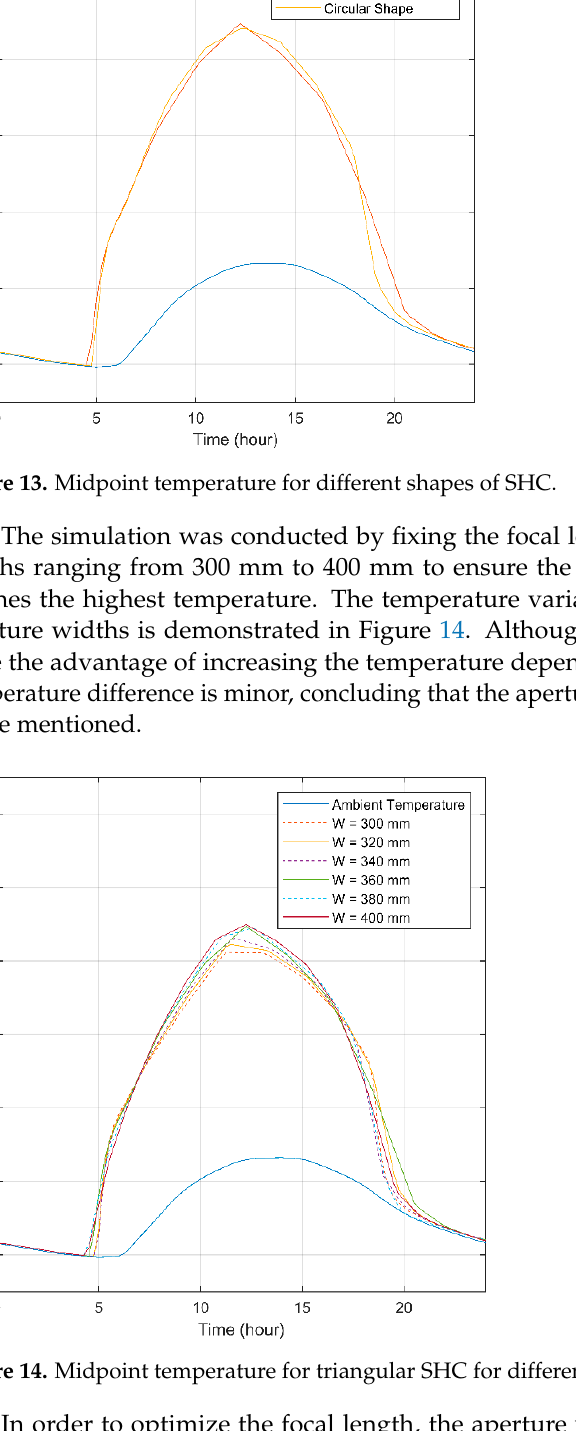
Figure 15. Midpoint temperature for triangular SHC for different values of focal length. 3.4. SHC Orientation’s Effect on the Thermal Behavior